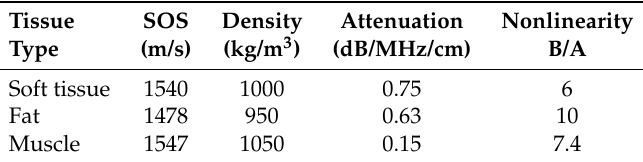
Table 1. Tissue map properties.